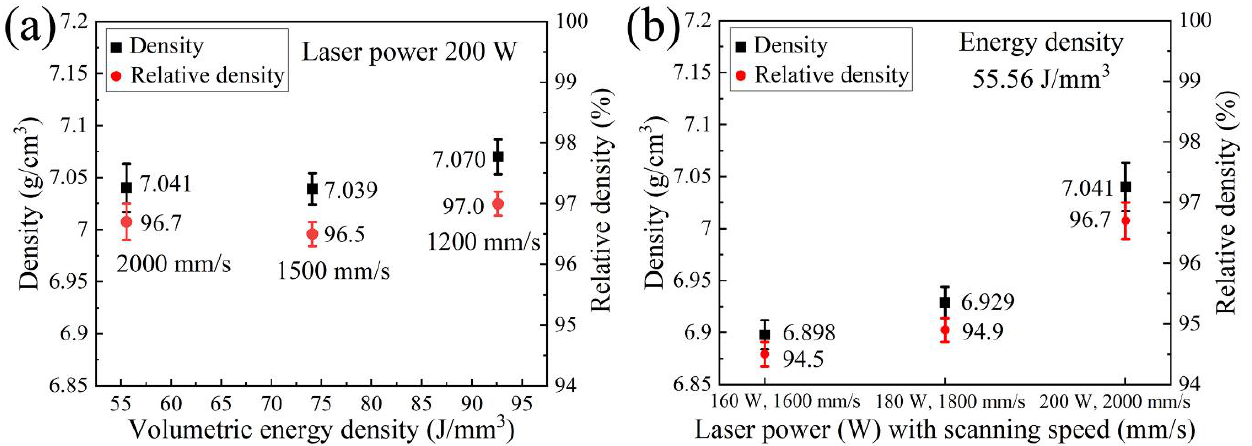
Figure 2. AD and RD of as-printed AlCoCr 0.75 Cu 0.5 FeNi specimens produced under ( a ) the same laser power of 200W with different scanning speeds and ( b ) the same VED of 55.56 J/mm 3 .